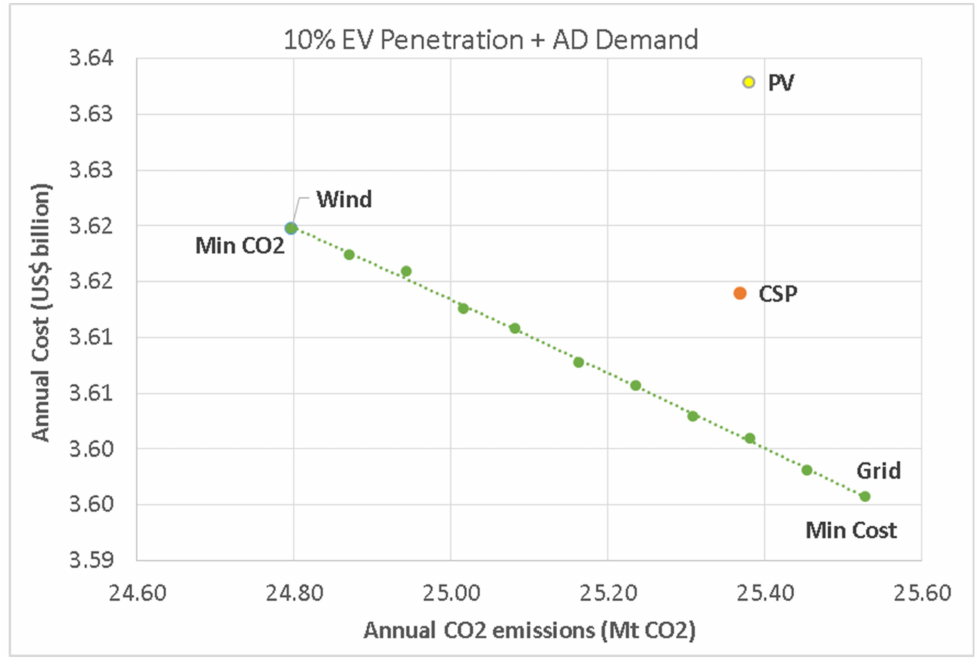
Figure 8. Trade-off between annual cost and CO 2 emissions in different case studies for meeting both 10% EV and Abu Dhabi city electricity demand. Table 4. The share of electricity generation for each energy generation technology and the number of RET equipment installed for each case study introduced in Figure